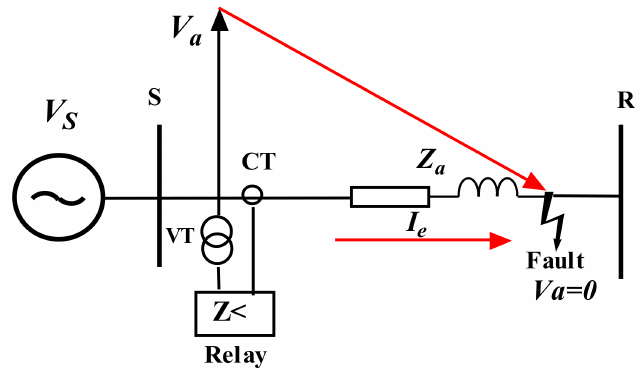
Figure 1. Distance protection